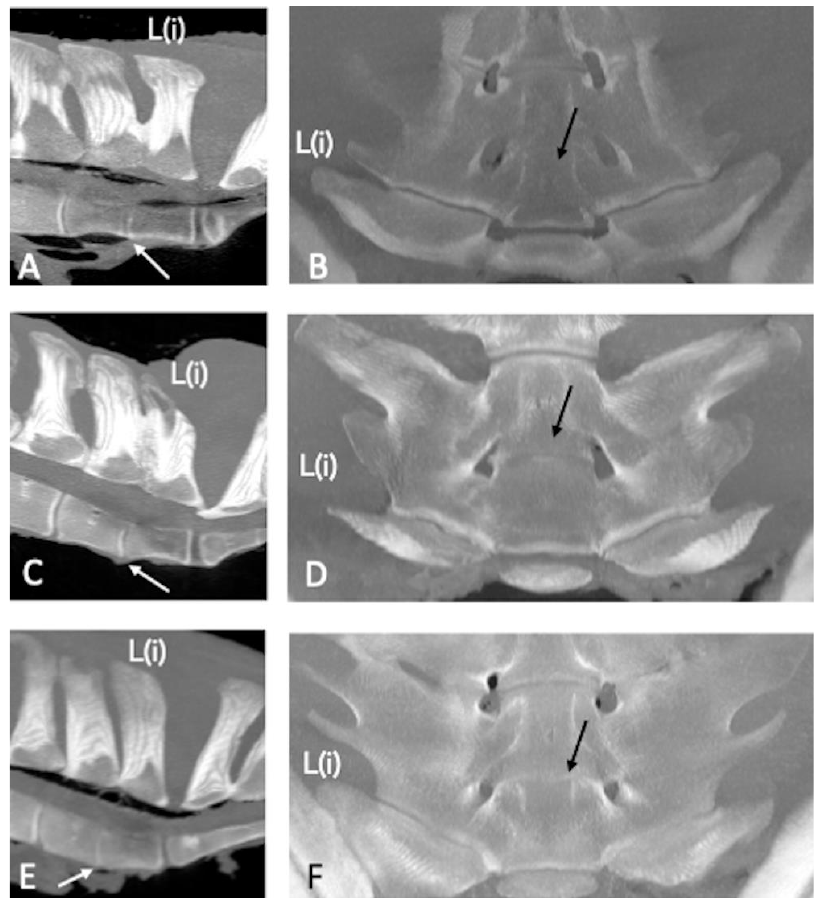
Figure 8. Sagittal ( A , C , E ); cranial is toward the left) and dorsal ( B , D , F ); cranial is toward the top) multiplanar reconstruction CT images of the lumbosacroiliac specimens 19, 25, and 33 using maximum intensity projection. ( A , C , E ) Note the marked narrowing of the L(ii)-L(i) intervertebral discs space (white arrows) with no visible disc space dorsally (dorsal fusion) in comparison with the L(iii)-L(ii) ones, associated with partial fusion of the respective spinous processes (SPs) in specimens 19 and 29. ( B , D , F ) The L(ii)-L(i) intervertebral disc space is not seen on the ventral aspect (black arrows) in concomitance with bilateral L(ii)-L(i) intertransverse joints (ITJs) fusion in all 3 specimens. L(iii): third to most caudal lumbar vertebra; L(ii): second to most caudal lumbar vertebra; L(i): most caudal lumbar vertebra.